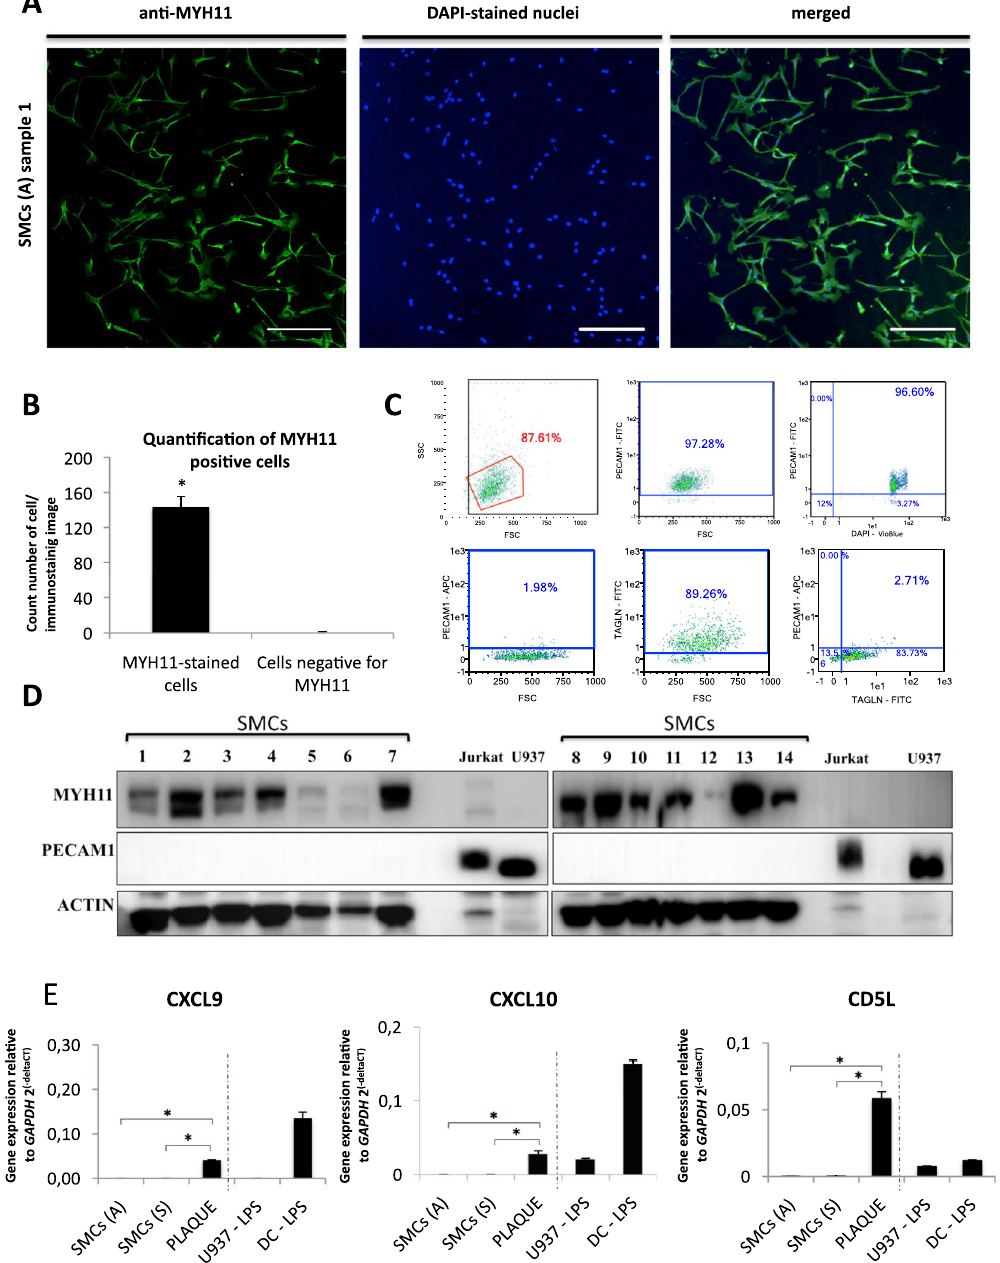
Figure 1. Quality control analysis. ( A ) Representative confocal images of MYH11-positive cells (left panel) and DAPI-stained cells (central panel) and merged (right panel). Magnification: the horizontal bars represent a scale of 250 μ m; ( B ) Quantification of MYH11-positive cells versus total number of cells (DAPI-stained nuclei). Data are mean ± SD. * p < 0.05. ( C ) Flow cytometry graphs indicating expression of endothelial marker PECAM1 and SMCs marker TAGLN in SMC cultures (lower panels) and PECAM1 detection in U937 as positive control (upper panels). ( D ) Western blot detection in all our SMCs cultures of MYH11 and PECAM1 with ACTIN as loading control. Positive detection of PECAM1 and negative detection of MYH11 in Jurkat and U937 cells. ( E ) Gene expression quantification of macrophages markers ( CXCL9 , CXCL10 and CD5L ) performed by qPCR using RNA extracted from: (i) SMCs from asymptomatic patients (average of 7 samples); (ii) SMCs from symptomatic patients (average of 7 samples); (iii) atheroma plaque (average of 3 samples); (iv) monocyte cell line U937 treated with LPS; (v) CD14 + monocyte-derived dendritic cells treated with